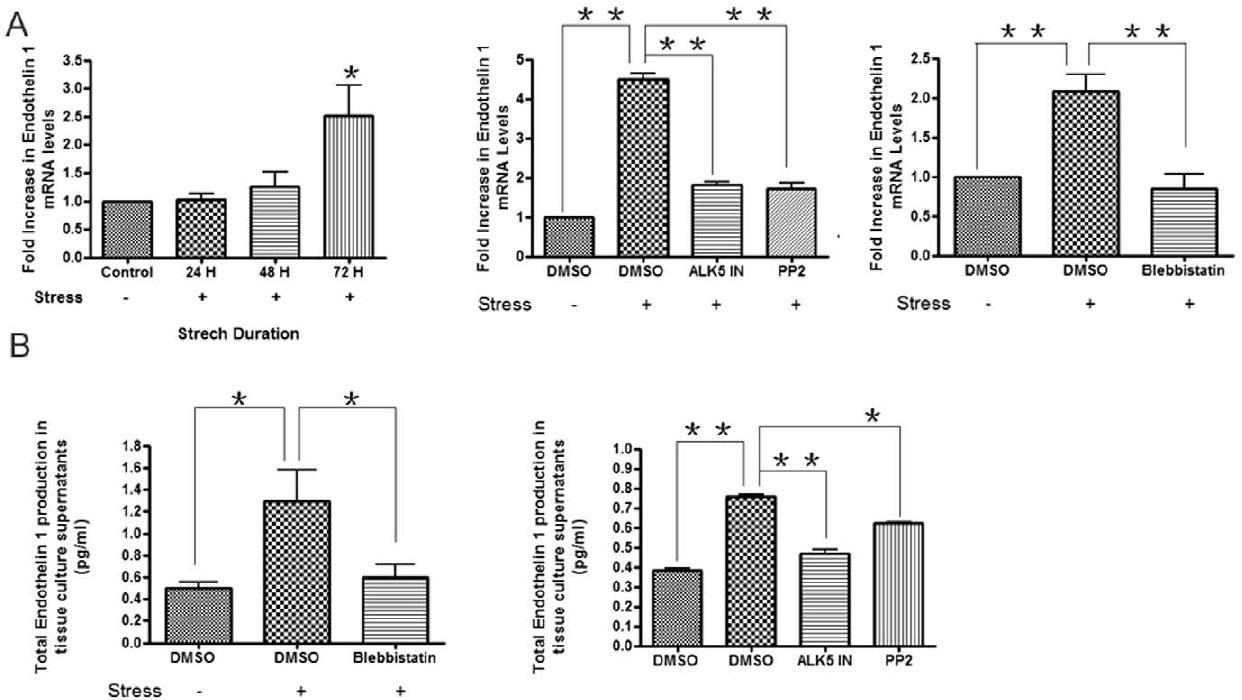
Figure 4. Strain induces endothelin-1 (ET-1) production. As described in Methods, equal numbers of HGF were seeded into plates containing collagen type I-coated membranes, and were treated with or without mechanical strain for 72 hours. Cells were treated with or without DMSO, the ALK5 inhibitor SB431542, PP2, or blebbistatin, as indicated. (A) Total RNA was harvested, and subjected to real-time PCR analysis with primers detecting ET-1. Expression values are adjusted to those of controls (18S) run in parallel. Experiments were performed on cells derived from three different individuals, with quadruplicate replicate samples. (B) Conditioned media was subjected to ELISA to detect ET-1. Data shown are the average value from three independent individuals (3 replicates per experiment ) 6 SE. *=p , 0.05; **=p ,